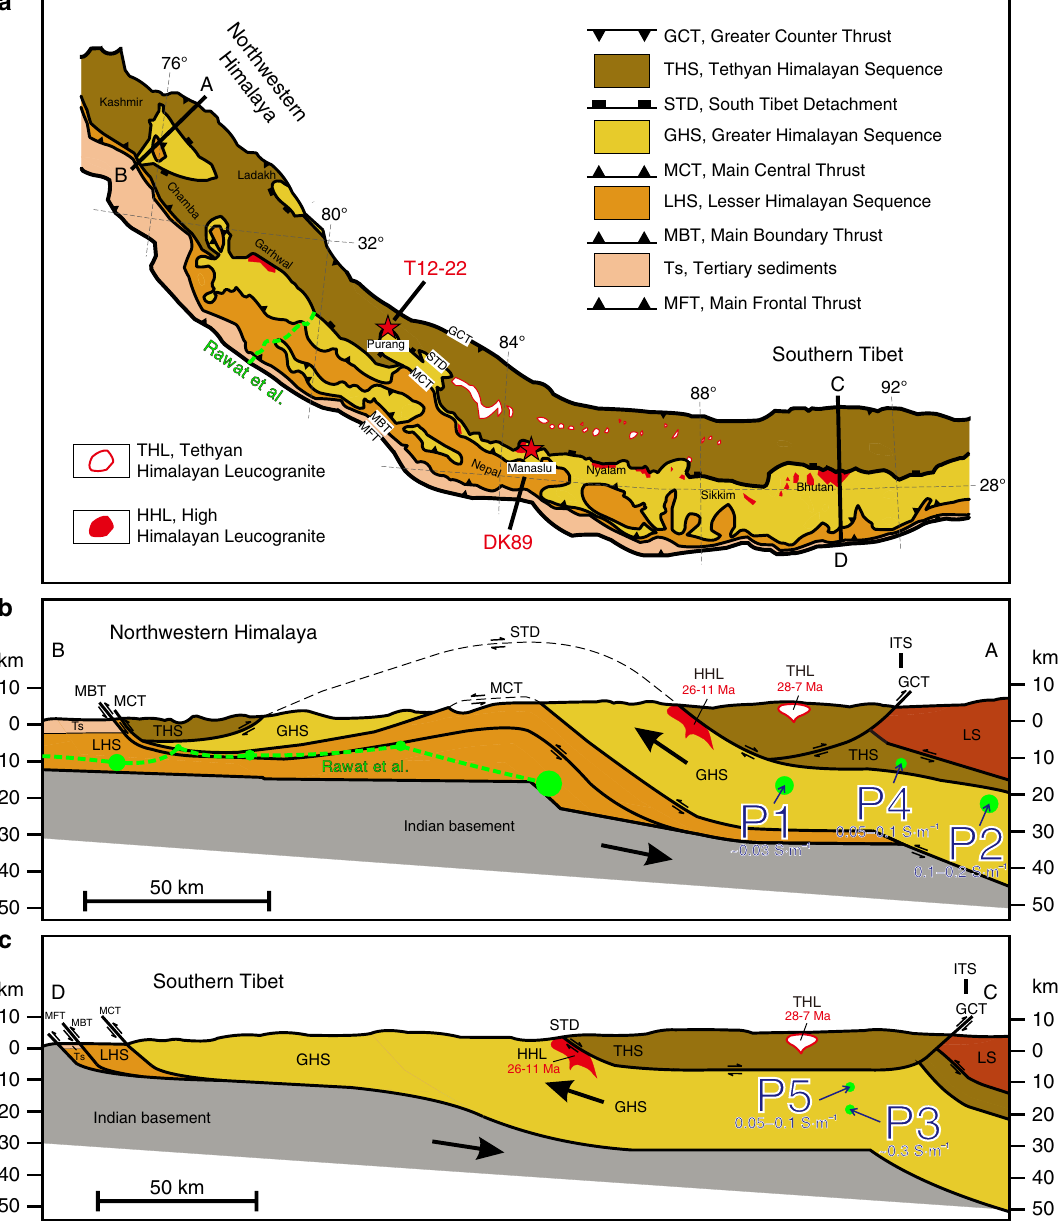
Fig. 1 Simpli fi ed geological map combined with the cross-sections of the northwestern Himalaya and southern Tibet. a The leucogranites used for electrical conductivity measurements (T12-22 in Purang county and DK89 in the base of the Manaslu pluton 41 , red stars on the geological map) were collected in the GHS near the STD. The location of the MT pro fi le probed by Rawat et al. 40 is labeled by the green dashed line. b In the northwestern Himalaya (cross- section A, B), the high electrical conductivity spots of ~0.03 S/m (15 – 20 km), 0.1 – 0.2 S/m (20 – 25 km), and 0.05 – 0.1 S/m (10 – 13 km) identi fi ed by magnetotelluric data (MT) 34 are labeled P1, P2, and P4, respectively. The green dashed line and circles, respectively, identify the high electrical conductivity layer and spots, as probed by Rawat et al. 40 . c The other spots at ~0.3 S/m (18 – 20 km) and 0.05 – 0.1 S/m (10 – 13 km) 17 are labeled P3 and P5 in the southern Tibet (cross-section C, D). The leucogranites emplaced just beneath the STD have been dated from 26 to 11 Ma, while those emplaced within the THS have been dated from 28 to 7 Ma 29 . a – c were adapted from Fig. 1 of Hashim et al. 22 . TS tertiary sediments, LHS Lesser Himalayan Sequence, GHS Greater Himalayan Sequence, THS Tethyan Himalayan Sequence, LS Lhasa terrane, ITS Indus-Tsangpo suture, MFT Main Frontal Thrust, MBT Main Boundary Thrust, MCT Main Central Thrust, STD South Tibet Detachment, GCT Great Counter Thrust, THL Tethyan Himalayan Leucogranite, HHL